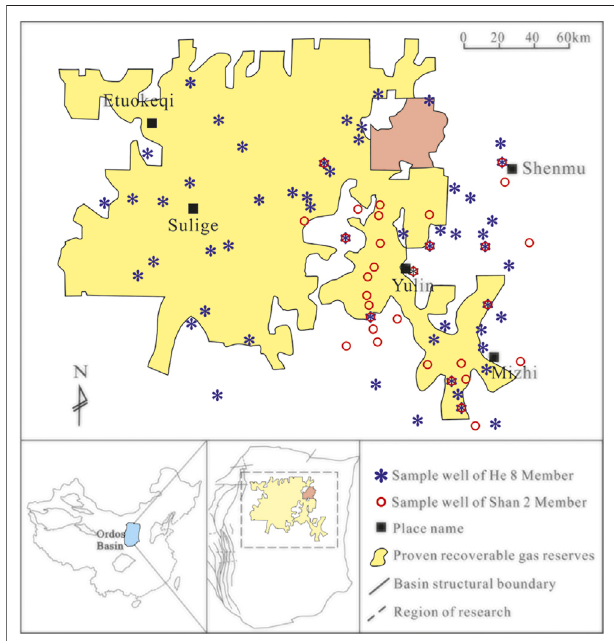
FIGURE 1 | Division of tectonic units and location of the